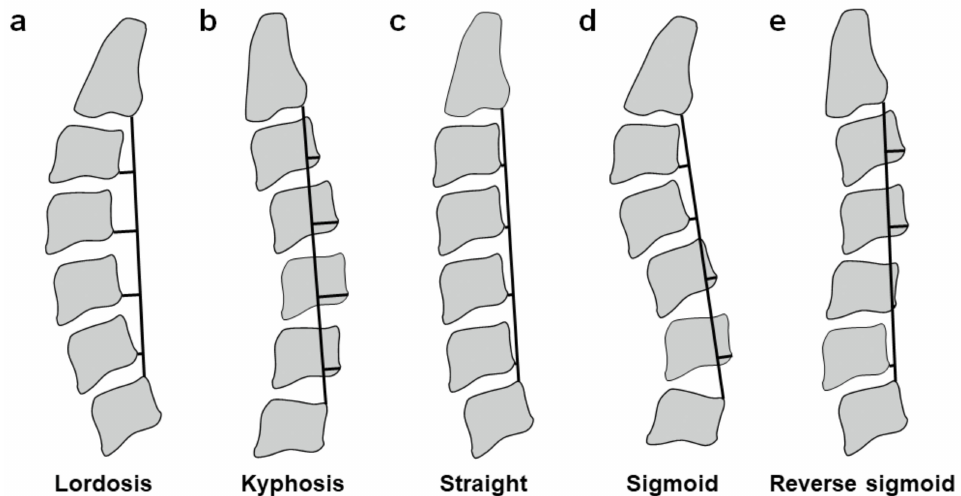
Figure 1. Schematic of the sagittal alignment of the cervical spine. On lateral cervical spine radio- graphs in neutral position, a line is drawn between the lower posterior edge of C2 and upper posterior edge of C7. The distances between the lower posterior edge of C3 to C6 and this line are measured. ( a ) When all the distances are anterior to the line and at least one is 2 mm or more, the sagittal alignment is defined as the “lordosis” type. ( b ) When all the distances are posterior to the line and at least one is 2 mm or more, the sagittal alignment is defined as the “kyphosis” type. ( c ) When all the distances are less than 2 mm anteriorly or posteriorly, the sagittal alignment is defined as the “straight” type. ( d ) When the upper cervical distance(s) is anterior but the lower cervical distance(s) is posterior, the sagittal alignment is defined as the “sigmoid” type. ( e ) When the upper cervical distance(s) is posterior but the lower cervical distance(s) is anterior, the sagittal alignment is defined as the “reverse sigmoid”